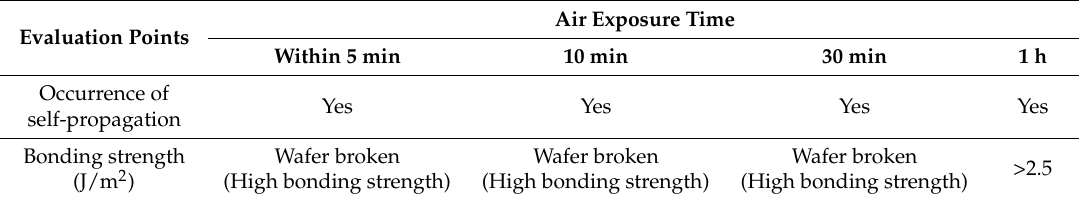
Table 2. Effect of air exposure time on the occurrence of self-propagation of the bonding area and on the bonding strength of atomic diffusion bonding for Au films immediately after